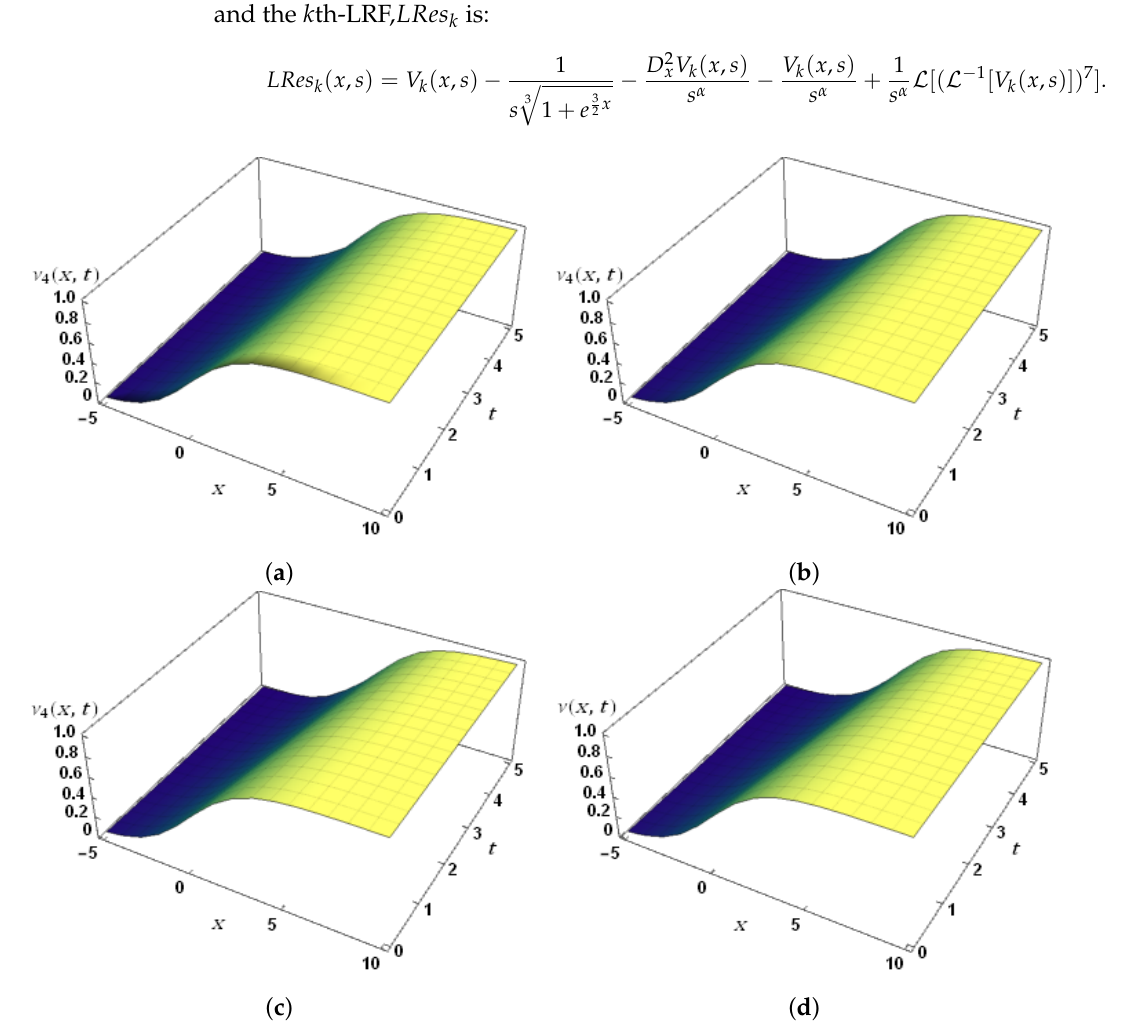
Figure 3. The surface graphs of the exact and 4th ASs for Equations (46) and (47): ( a ) ν 4 ( x , t ) when α = 0.6, ( b ) ν 4 ( x , t ) when α = 0.8, ( c ) ν 4 ( x , t ) when α = 1, and ( d ) exact solution ( α =